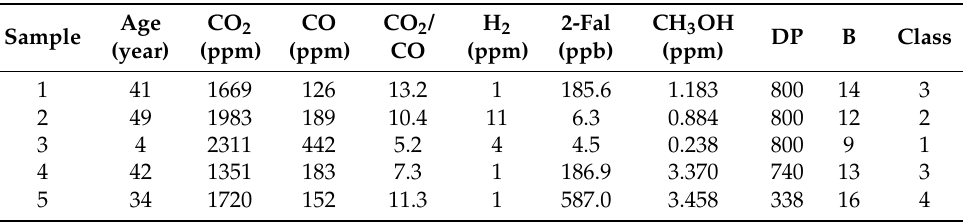
Table 4. Details of dissolved gases, furan concentrations, methanol in oil samples, DP of the paper samples, value of parameter B, and the class of each transformer.